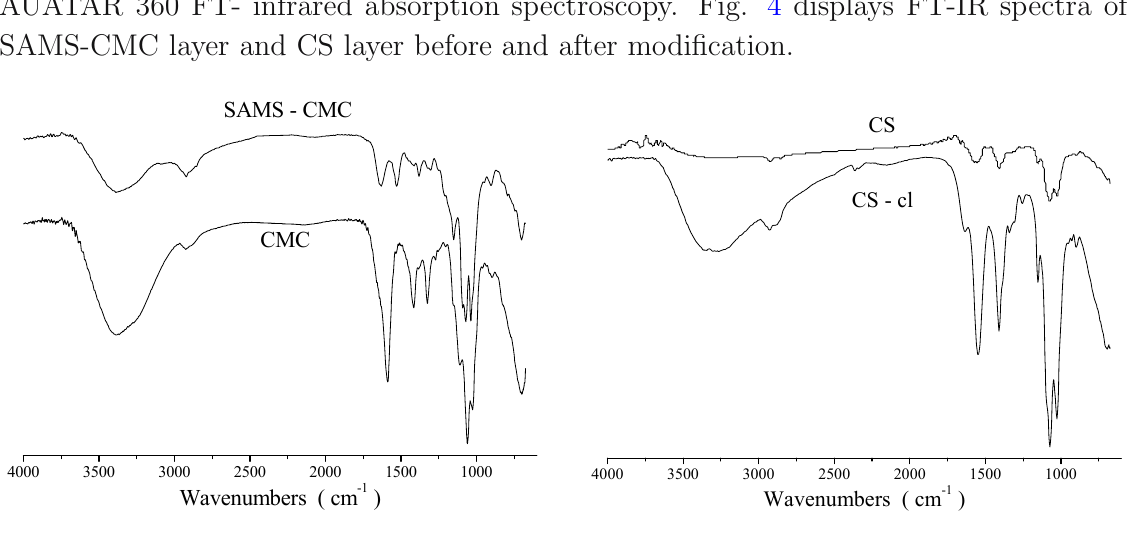
Fig. 4 Infrared spectra of CMC, crosslinked SAMS-CMC, CS and crosslinked CS (CS -